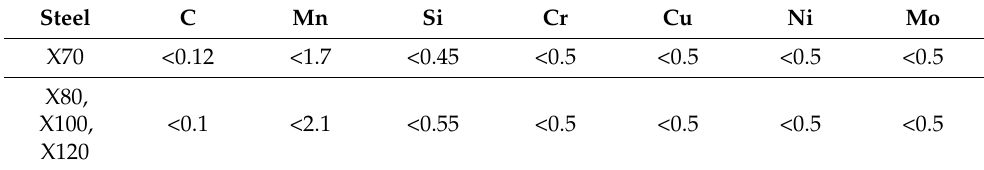
Table 4. Chemical composition of steels according to GOST ISO 3183-2015, wt%.